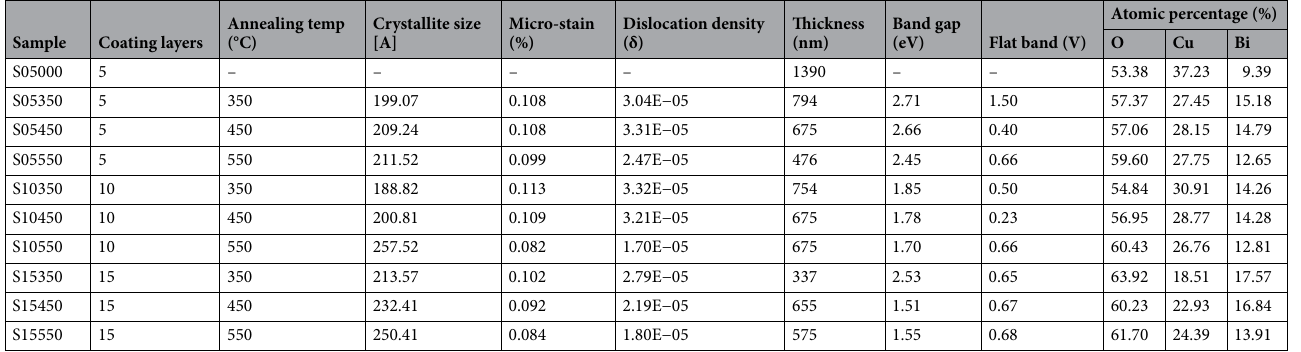
Table 1. Crystallographical parameters of